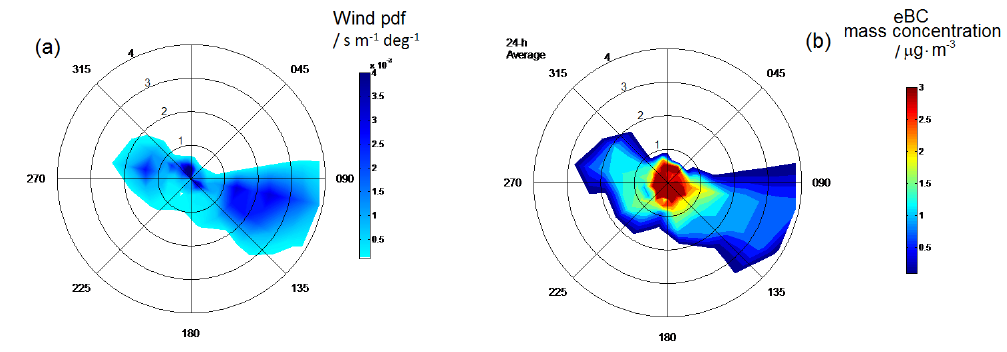
Figure 3. Wind rose and dependence of eBC on wind. ( a ) Occurence rose diagram showing the joint probability density function of wind speed and direction vs. both wind speed and direction; ( b ) 24-h average eBC concentration vs. both wind speed and